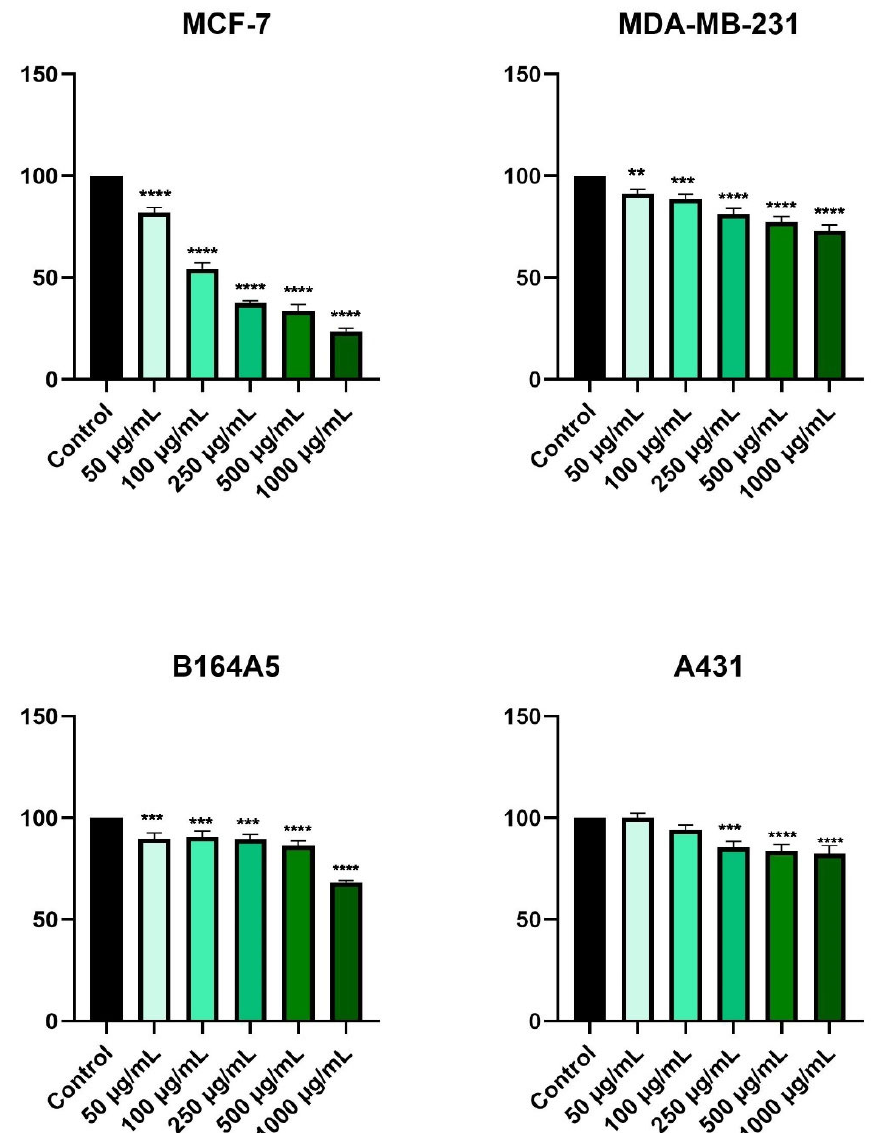
Figure 3. In vitro evaluation of the effect of HPex (50, 100, 250, 500, and 1000 µ g/mL) on cell viability on MCF-7, MDA-MB-231, B164A5, and A43, after 24 h of treatment. The results are presented as cell viability percentage (%) normalized to control (unstimulated) cells and are expressed as mean values ± SD of three independent experiments performed in triplicate. For statistical analysis